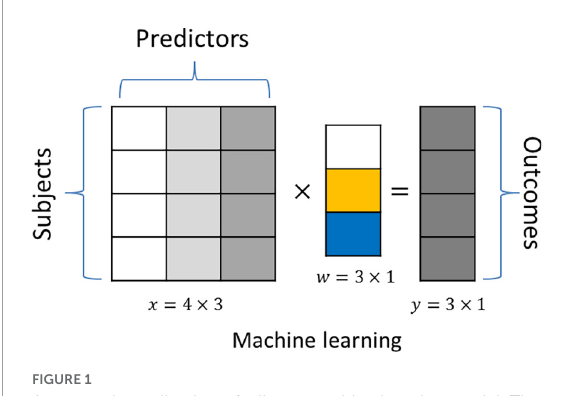
FIGURE1 An example application of a linear machine learning model. The “outcome” y is predicted by the linear combination of three predictors ( x ), and we aim to identify the coefficient vector w